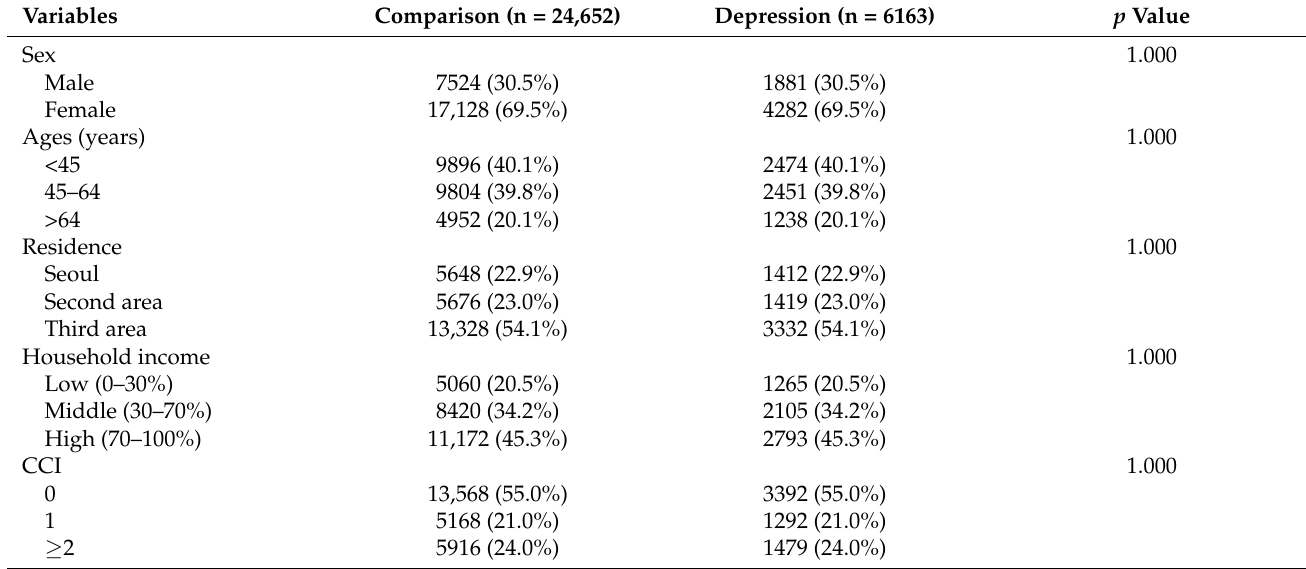
Table 2. Characteristics of the enrolled participants in depression: comparison vs. depression.